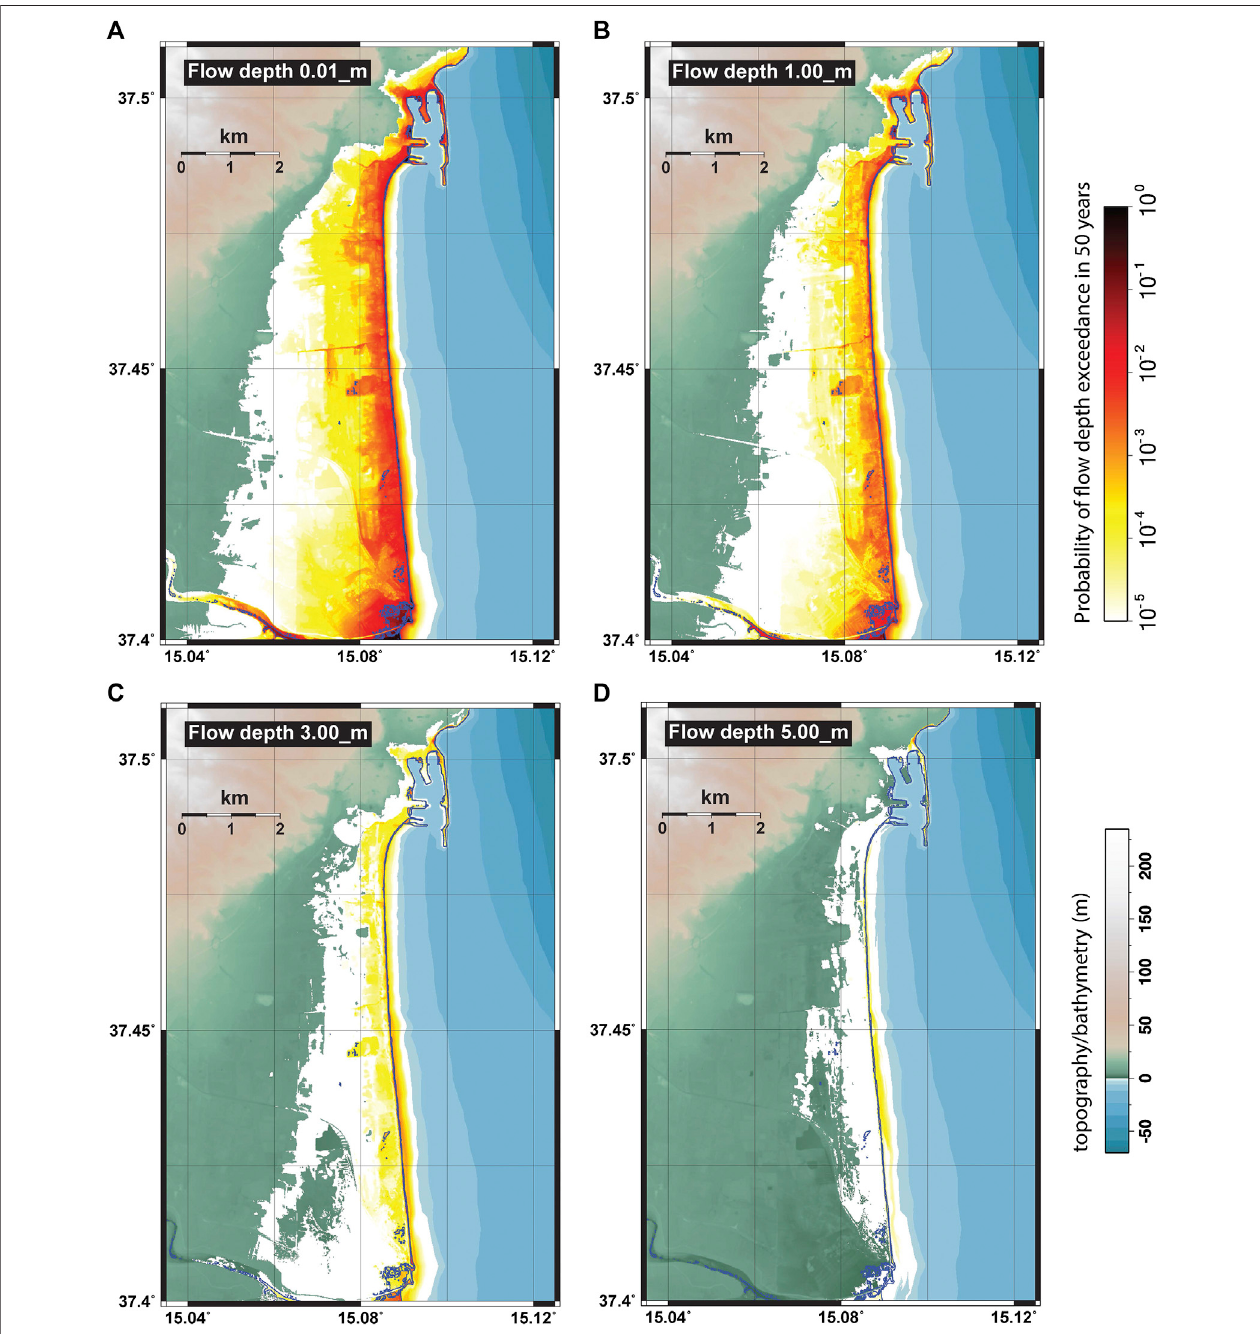
FIGURE8| Probabilityofexceedancewithin50yearsof fl owdepthof (A) 1 cm (B) 1 m (C) 3 m,and (D) 5 m,forCataniaandneighboringareas.Thezero-elevation contour line for the undeformed topography is shown in blue.